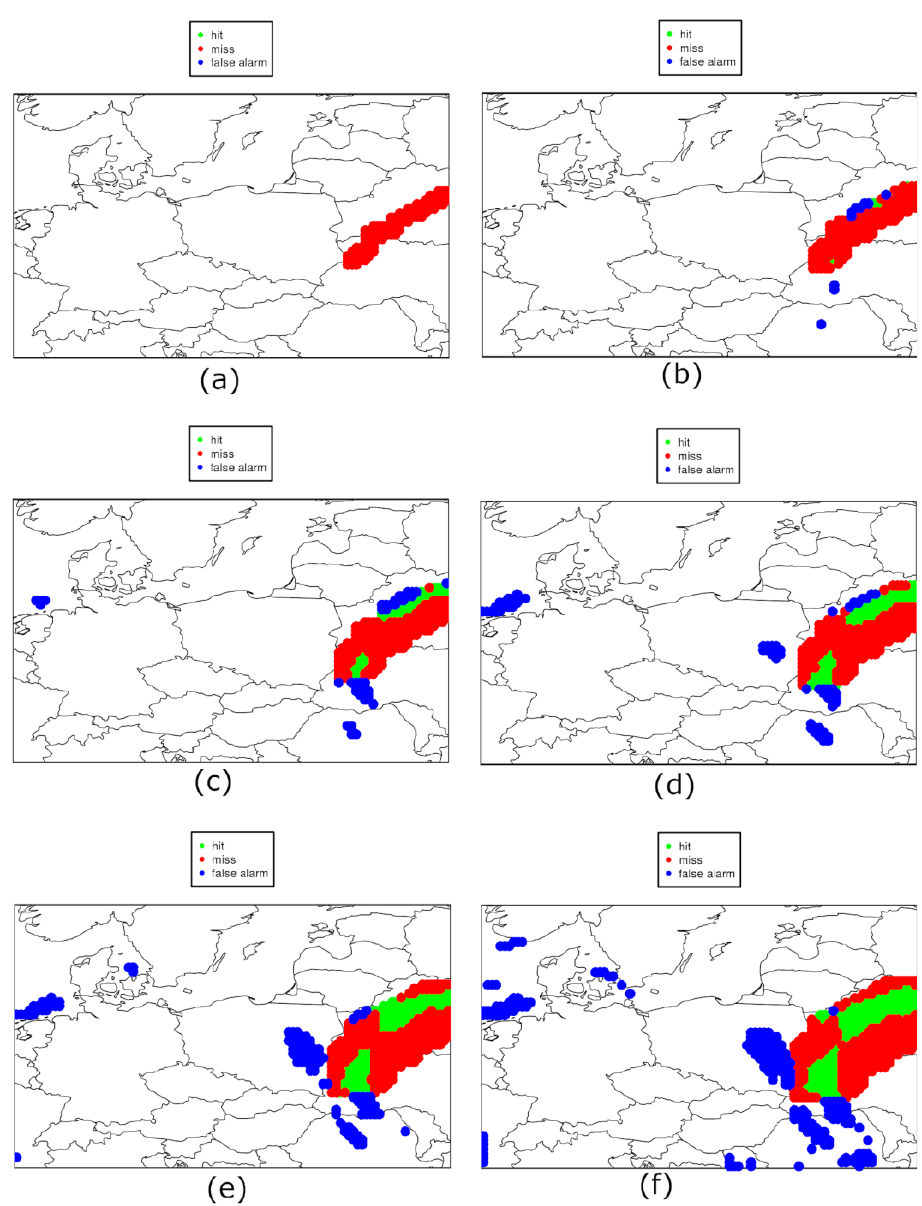
Figure 3. Results of the trained system with respect to the size of the front. Only one point of the front ( a ); additional one point ( b ); additional two points ( c ); additional three points ( d ); additional four points ( e ); additional five points ( f ).